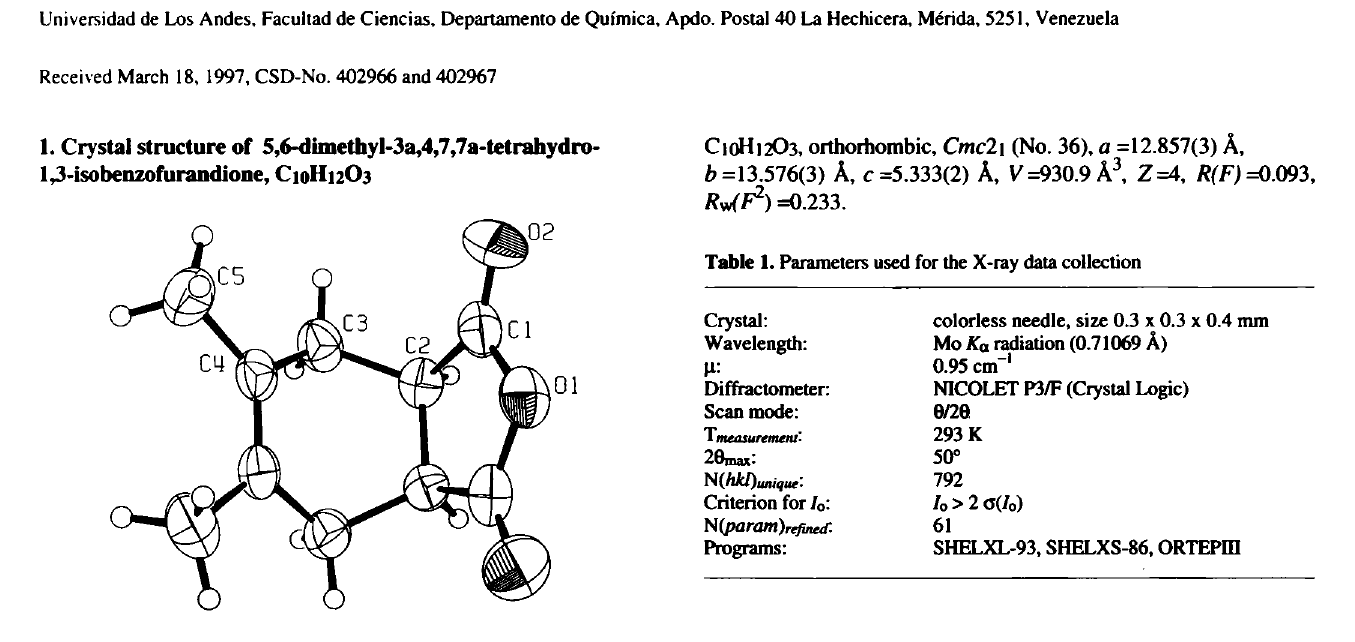
Table 2. Final atomic coordinates and displacement parameters (in